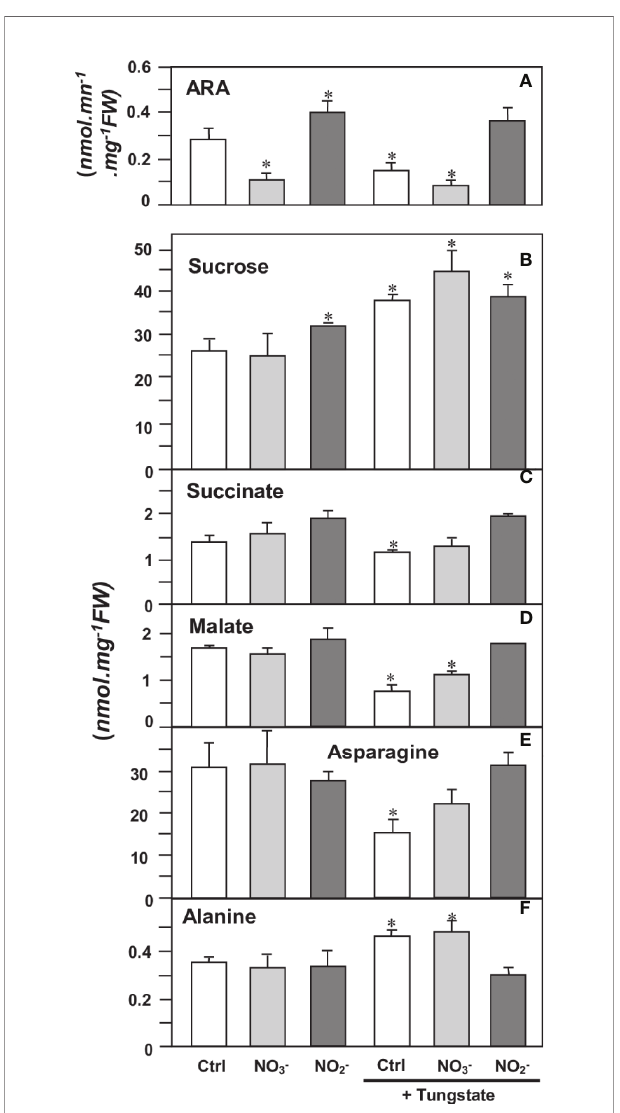
FIGURE 9 | Effects of NR effectors on nitrogenase activity and metabolite contents in Medicago truncatula nodules. 4 wpi-old nodules were incubated for 4 h in the presence of either 10 mM nitrate (NO 3 − ), 1 mM nitrite (NO 2 − ), or 1 mM tungstate (Tg). (A) , nitrogenase activity (estimated as ARA); (B) , sucrose; (C) , succinate; (D) , malate; (E) , asparagine; (F) , alanine. Data are means ± SE of three biological replicates. Each measure was realized in three technical replicates. Asterisks * indicate signi fi cant difference at P<0.05, when compared with the control (Ctrl) according to Student ’ s t